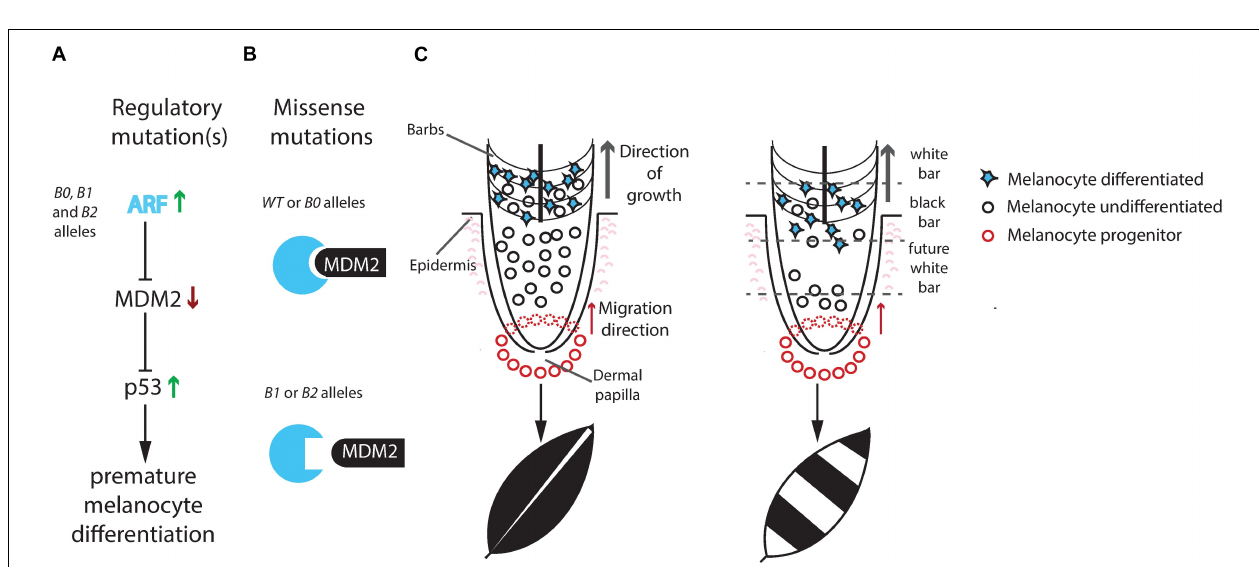
FIGURE 2 | Phenotypes and alleles at the Sex-linked barring ( CDKN2A ) locus in chicken. (A) Female and male Coucou de Rennes chicken illustrating the Sex-linked barring phenotype caused by the B1 allele. (B) Sex-linked barring alleles and associated sequence variants. SNP1 and SNP2 are non-coding while SNP3 and SNP4 constitute non-synonymous changes in the region encoding the MDM2 binding domain. Photo credit: (A) Hervé Ronné, Ecomusée du pays de Rennes. From Schwochow-Thalmann et al. (2017).